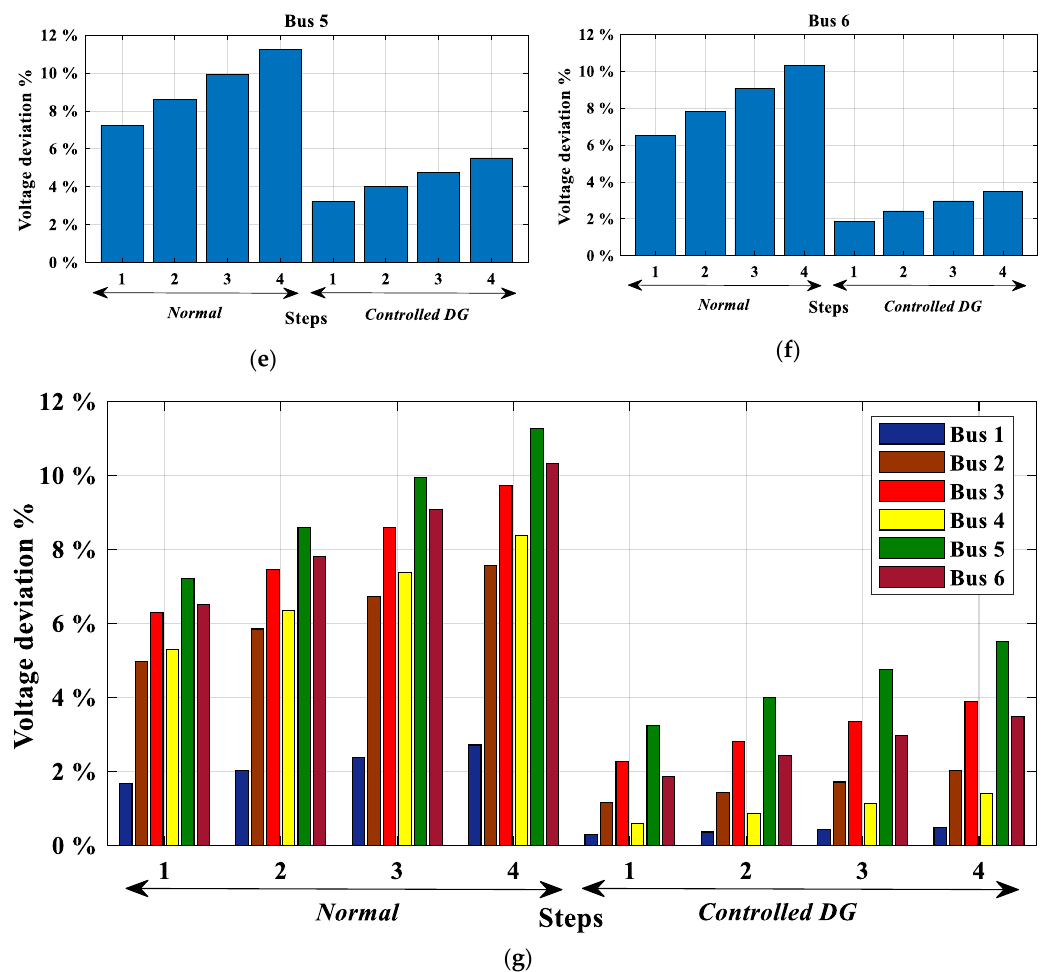
Figure 6. Voltage deviation % for busbars: ( a ) Voltage deviation % for busbar No. 1; ( b ) Voltage deviation % for busbar No. 2; ( c ) Voltage deviation % for busbar No. 3; ( d ) Voltage deviation % for busbar No. 4; ( e ) Voltage deviation % for busbar No. 5; ( f ) Voltage deviation % for busbar No. 6; ( g ) Voltage deviation % for all busbars.